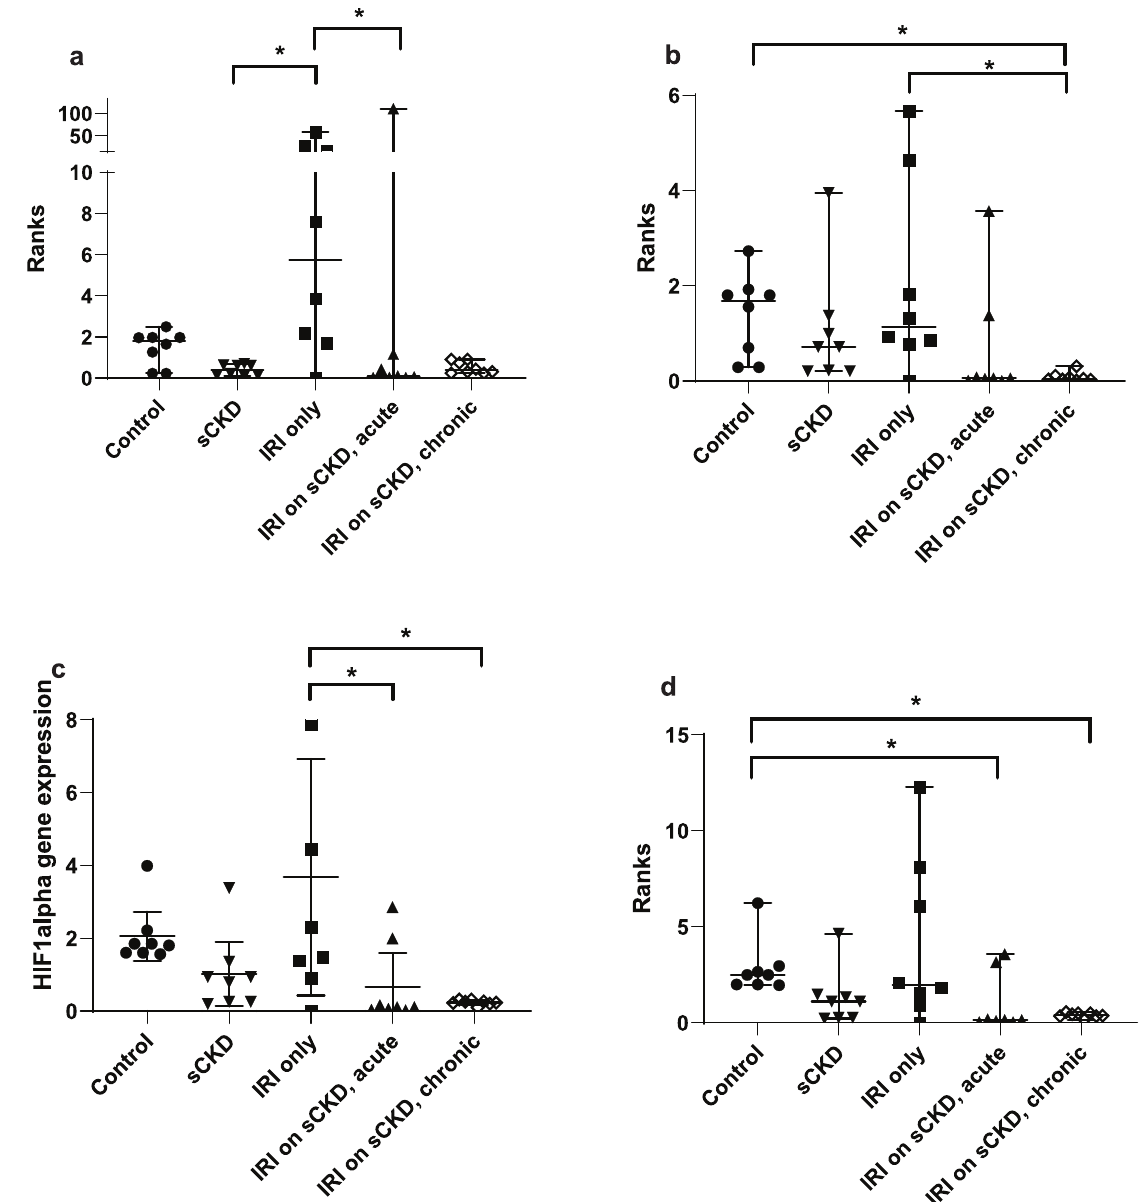
Fig 7. Expression or rank difference between groups of HIF1 α after IRI and normalised to a) 18S , b) GAPDH , c) PABPN1×HMBS , d) ACTB×PABPN1 . Data are means (one-way ANOVA) or medians (Kruskal Wallis) and 95% CI (n � 6). � p < 0.05, �� p < 0.01, ��� p <